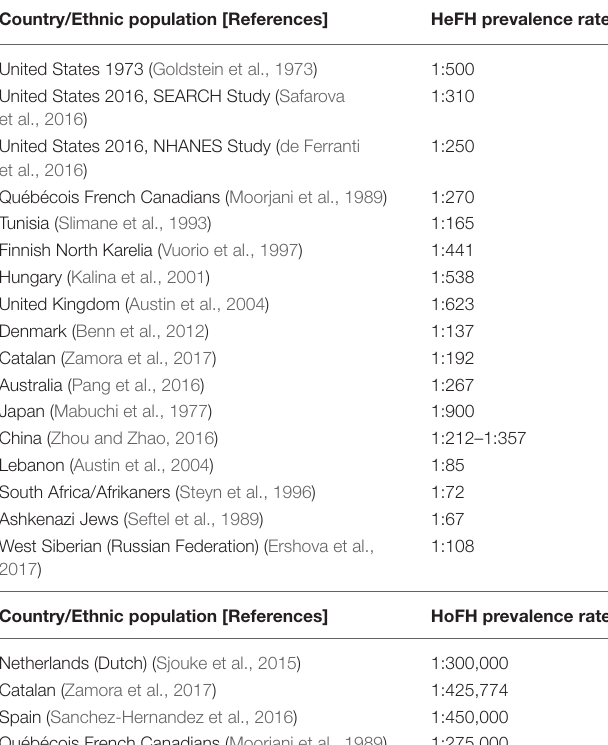
TABLE 1 | Reported prevalence rates of heterozygous familial hypercholesterolemia (HeFH) and homozygous familial hypercholesterolemia (HoFH) in various countries/ethnic